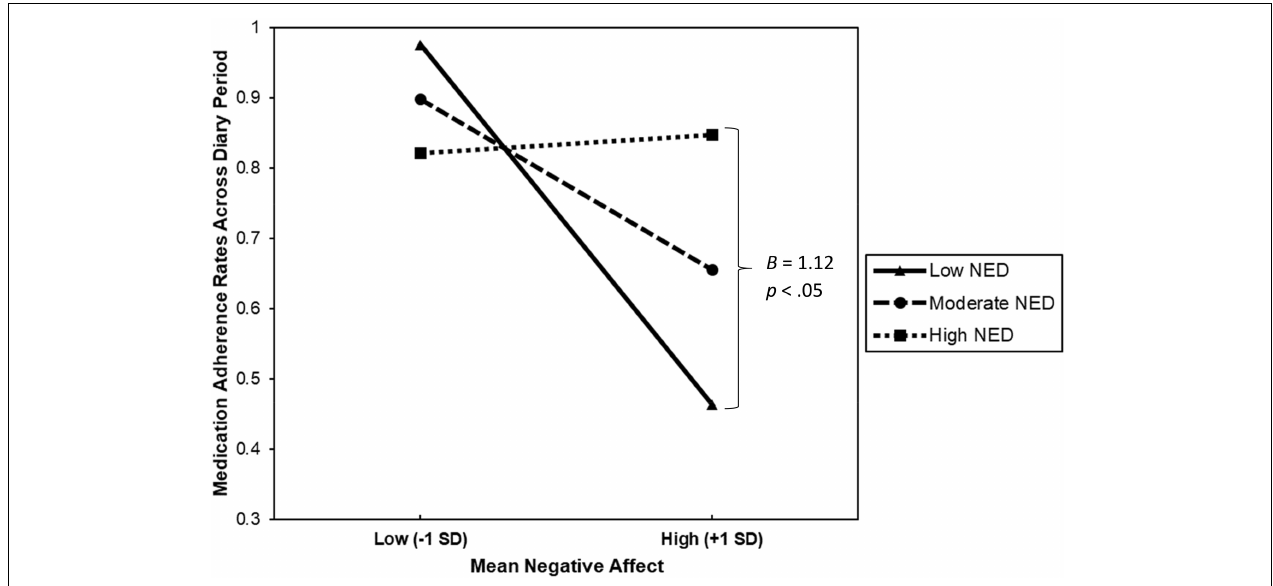
FIGURE 1 | This figure describes the interaction between mean negative affect and negative emotion differentiation (NED) when predicting medication adherence rates across the 58-week diary period among 23 patients with Multiple Sclerosis.